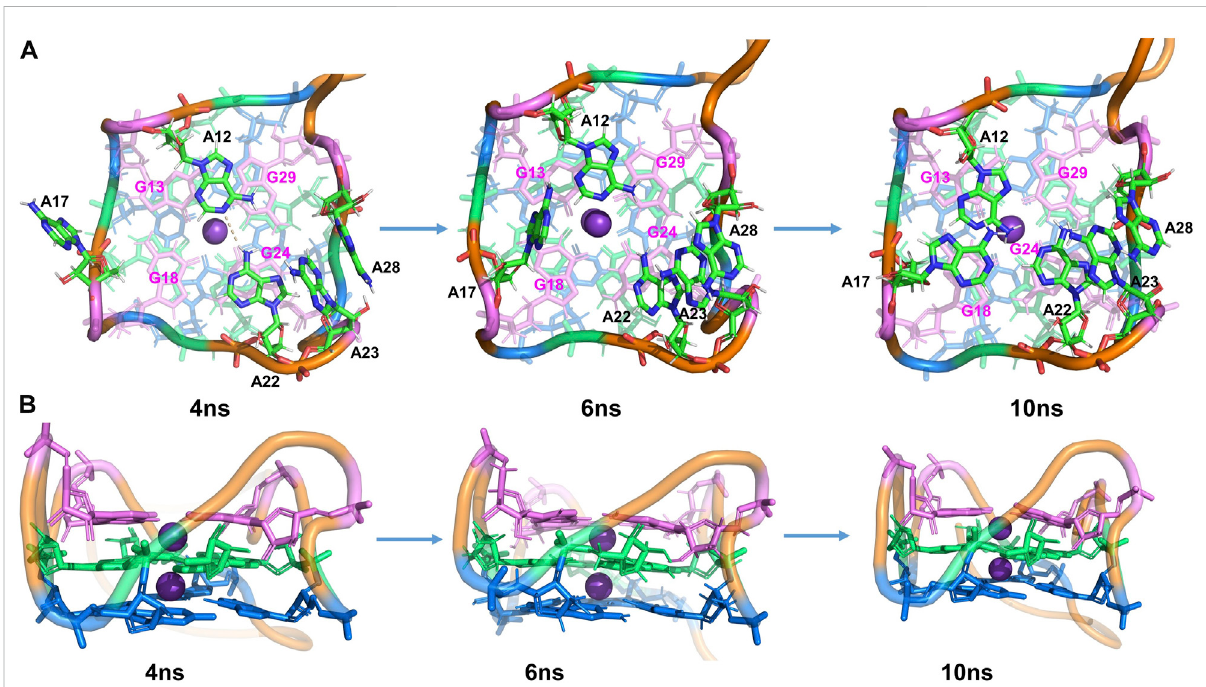
FIGURE 3 Structural analysis of MD simulation on wild-type Mango-II without ligand: the process of structural change during the MD (4 ns, 6 ns, 10 ns snapshots). (A) : top view. (B) : Side